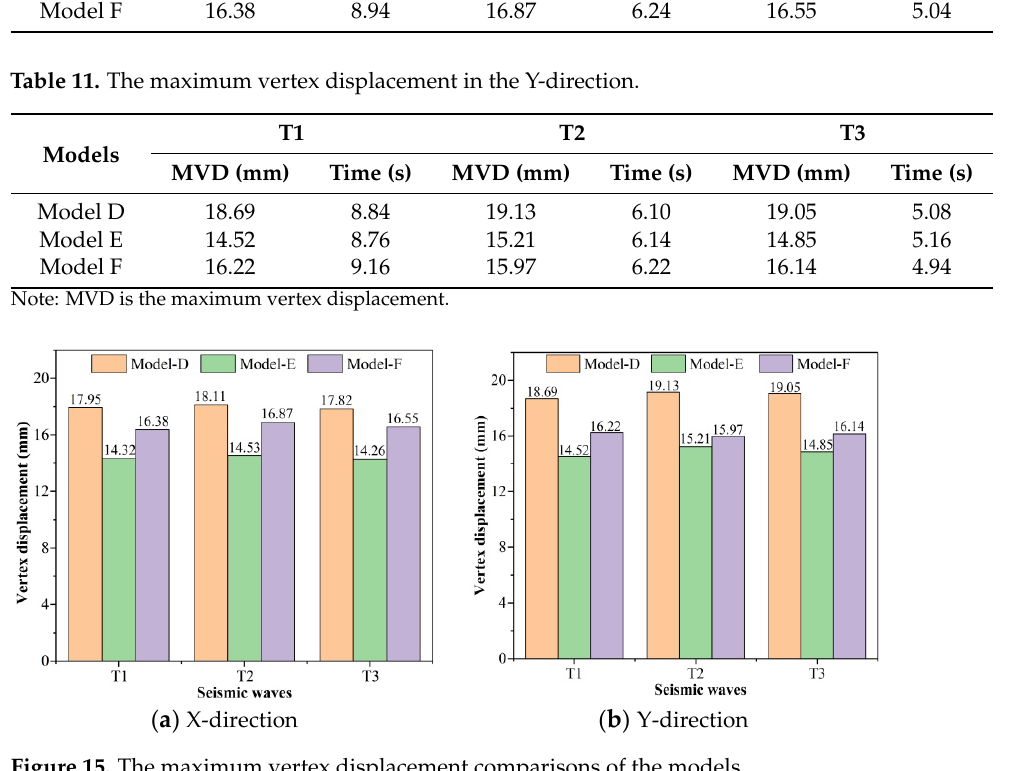
Figure 15. The maximum vertex displacement comparisons of the models.